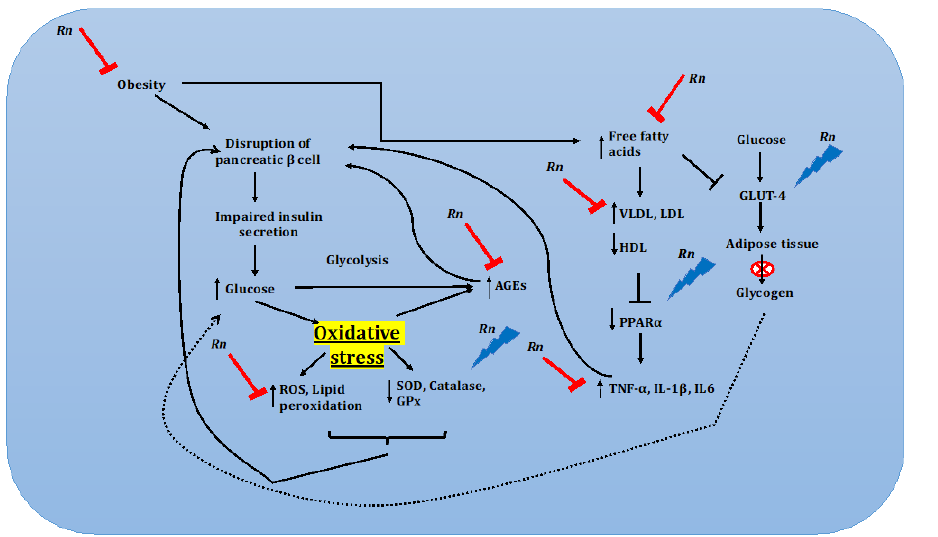
Figure 2. Rhinacanthus nasutus (Rn) and its beneficial properties regarding diabetes. Rn inhibits the production of Advanced glycation end-product (AGEs), prevents the increase in very low-density lipoprotein (VLDL) and low-density lipoprotein, and prevents the decrease in high density lipoprotein (HDL). Rn prevents reactive oxygen species (ROS) damage by activating superoxide dismutase (SOD) catalase and glutathione peroxidase (GPx). Rn also regulates peroxisome proliferator-activated receptor (PPAR ) and glucose transporter type 4 (GLUT-4).